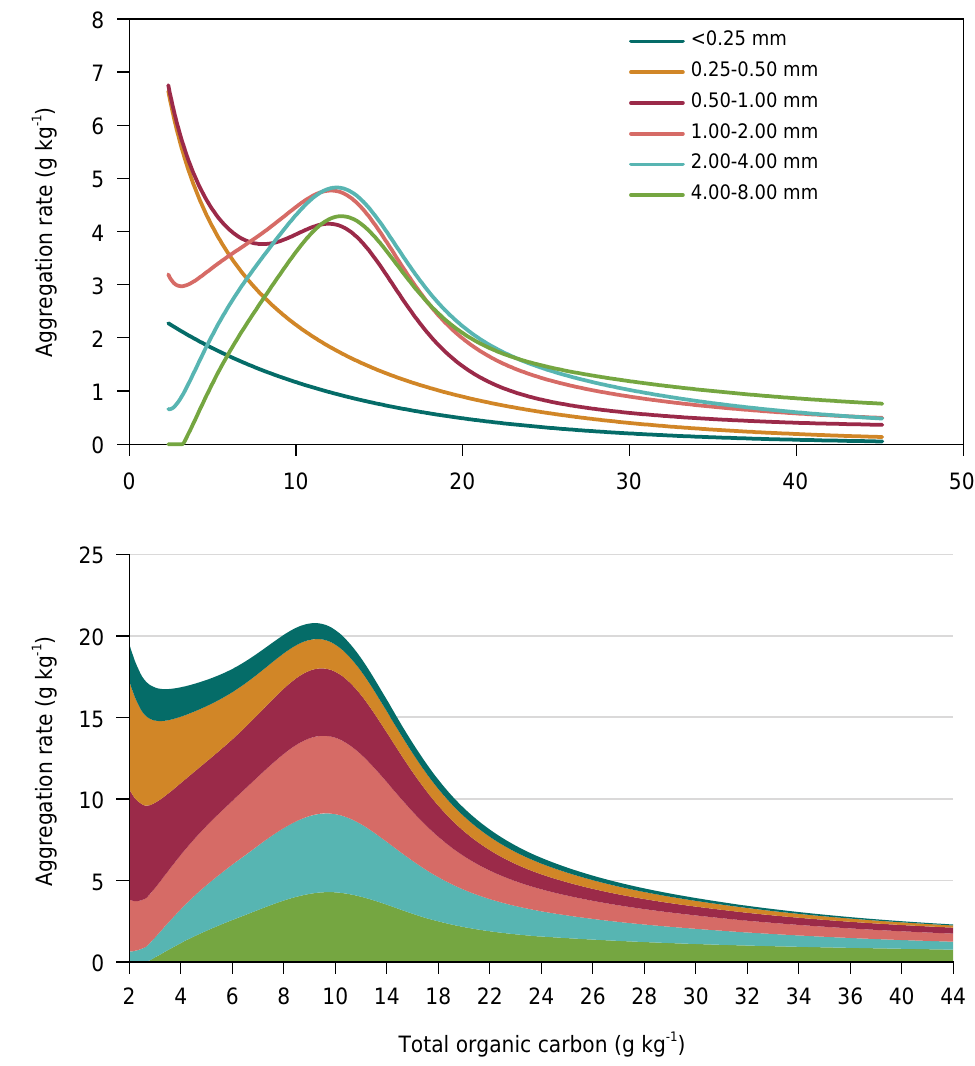
Figure 3. Aggregation rate of size classes of water-stable aggregates as a function of total organic carbon. Individual (a) and stacked (b) lines are